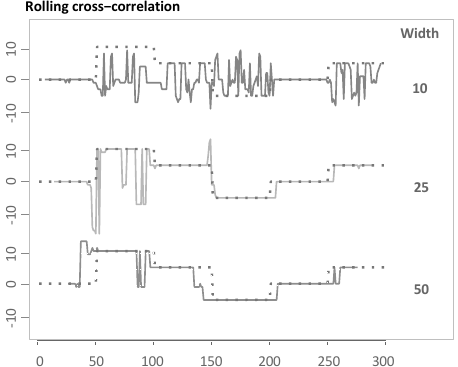
Figure 8. Time-dependent lag structure estimate through Rolling Cross-Correlation (RCC) for differ- ent window